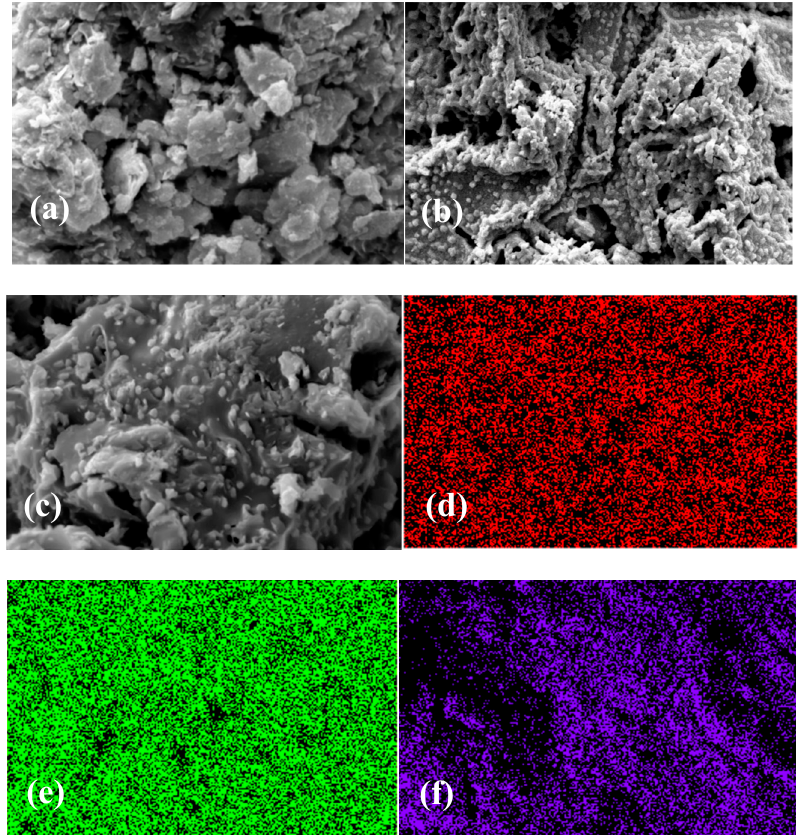
Figure 2. Scanning electron microscopy (SEM) images of ( a ) MMT-k10, ( b ) CuFe 2 O 4 , ( c ) Figure2. Scanningelectronmicroscopy(SEM)imagesof( a )MMT-k10,( b )CuFe 2 O 4 ,( c )CuFe 2 O 4 / MMT-k10, CuFe 2 O 4 /MMT-k10, and EDS mapping images of Cu ( d ), Fe ( e ), and O ( f ) for CuFe 2 O 4 /MMT-k10. and EDS mapping images of Cu ( d ), Fe ( e ), and O ( f ) for CuFe 2 O 4 /